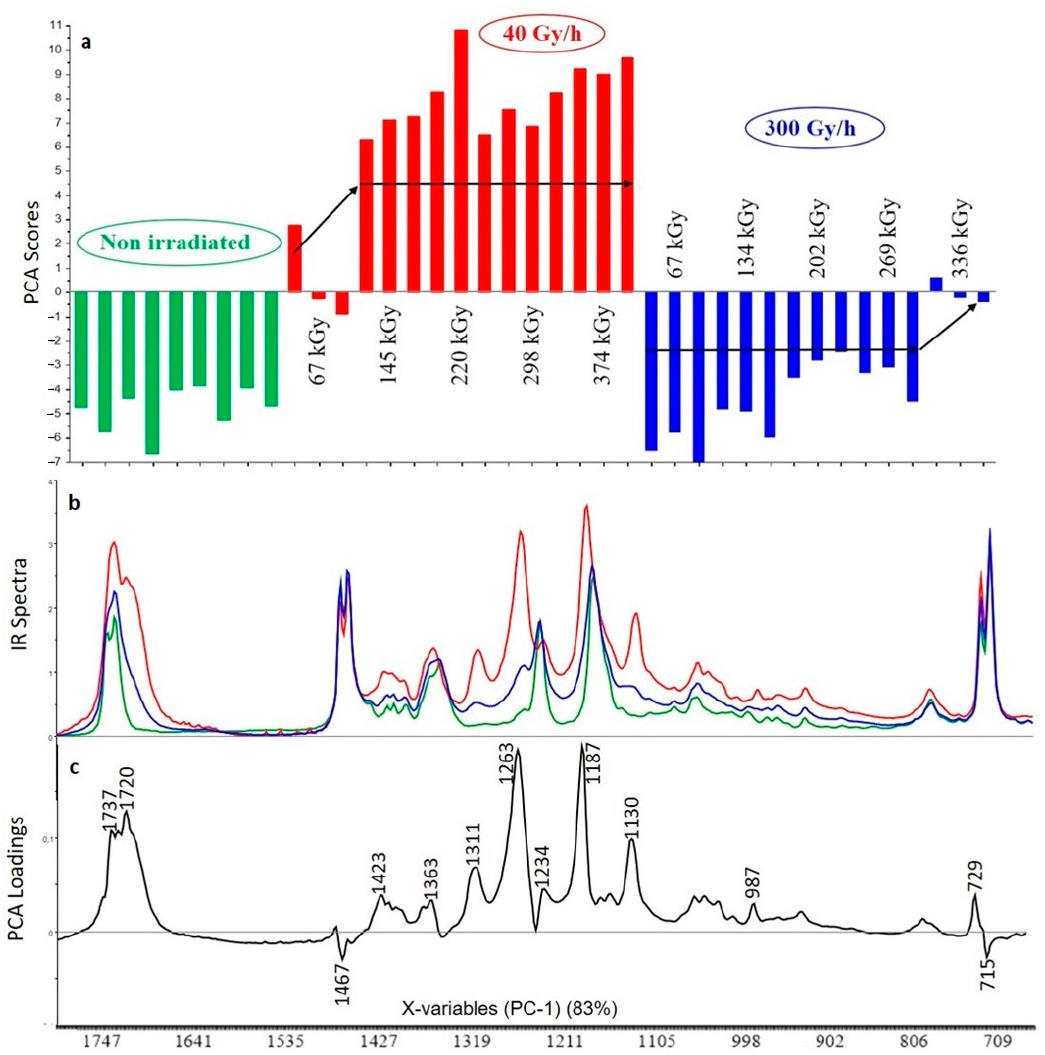
Figure 6. PCA scores ( a ), FTIR spectra for highest dose ( b ) and PCA loadings ( c ) of the first principal component (PC1) for the analysis of XLPE with Irganox PS802 (green: unaged samples, red: samples irradiated at 40 Gy/h, blue: samples irradiated at 300 Gy/h).